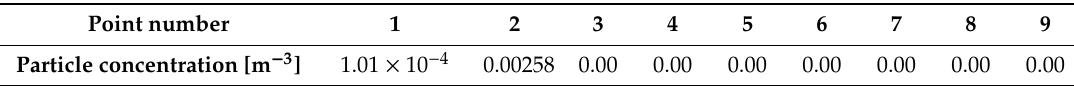
Table 1. Particle concentration in the reference points of simulation 10-235-5.